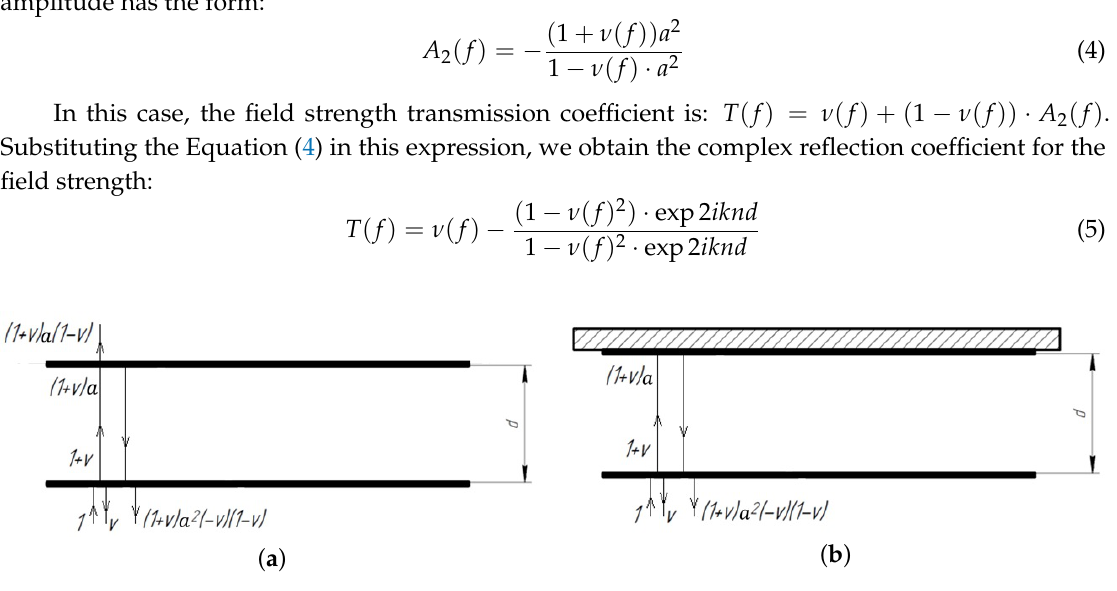
Figure 1. The reflection from the boundary “air-dielectric-air” ( a ). The reflection from the boundary “air-dielectric-metal” ( b